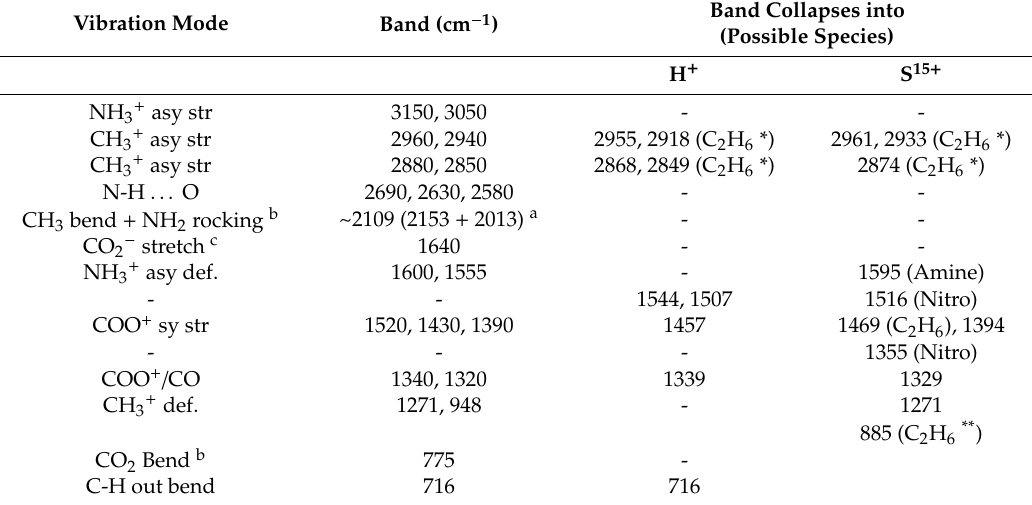
Table 1. Evolution of valine bands as the 1.5 MeV H + and 230 MeV S 15+ projectile fluences increase. Band identification and their band wavenumbers for valine before irradiation; wavenumber of products after H + and S 15+ irradiation. (a) split band at low temperature: da Costa and da Silveira [33]; (b) Kumar [35]; (c) Façanha Filho et al. (2008) [36]. Attributions are tentative. (*) strong absorbance; (**) low absorbance.